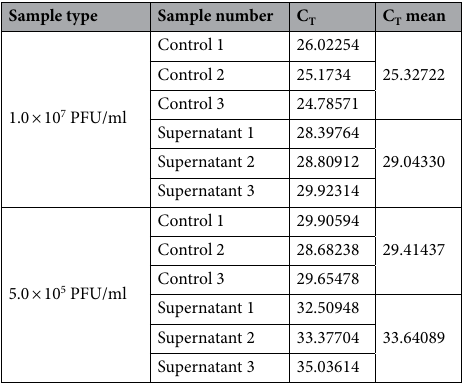
Table 2. Quantitative results (n = 3) of RT-PCR tests on viral RNA from Influenza A H1N1 virus unexposed (Control) and supernatant virions after exposure to Si3N4 powder (Supernatant). Two different viral concentrations were tested as indicated in the left column of the table. In n = 3 tests performed on Si3N4 powder pellets (not shown in the table), the viral RNA was undetermined.